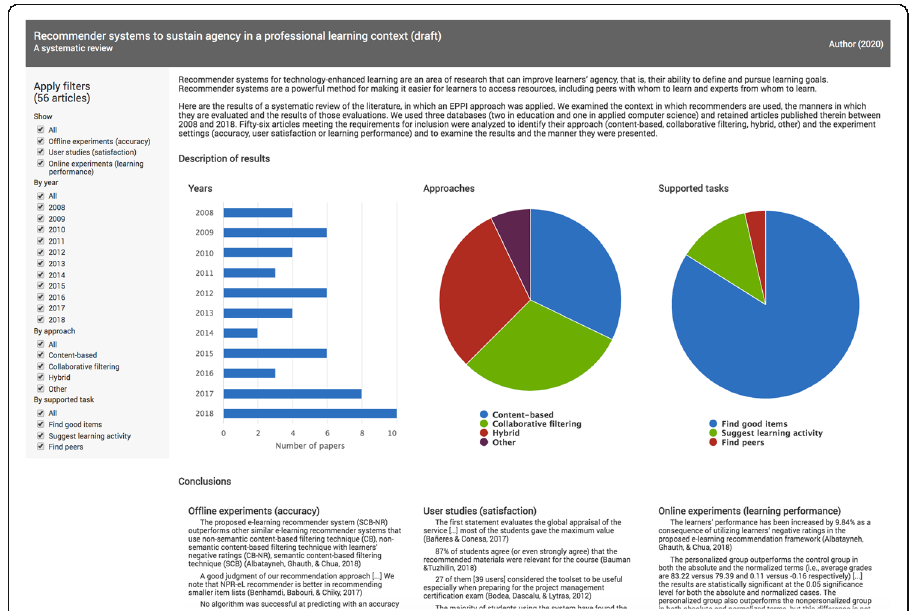
Fig. 13 Visualization tool for the conclusions of articles